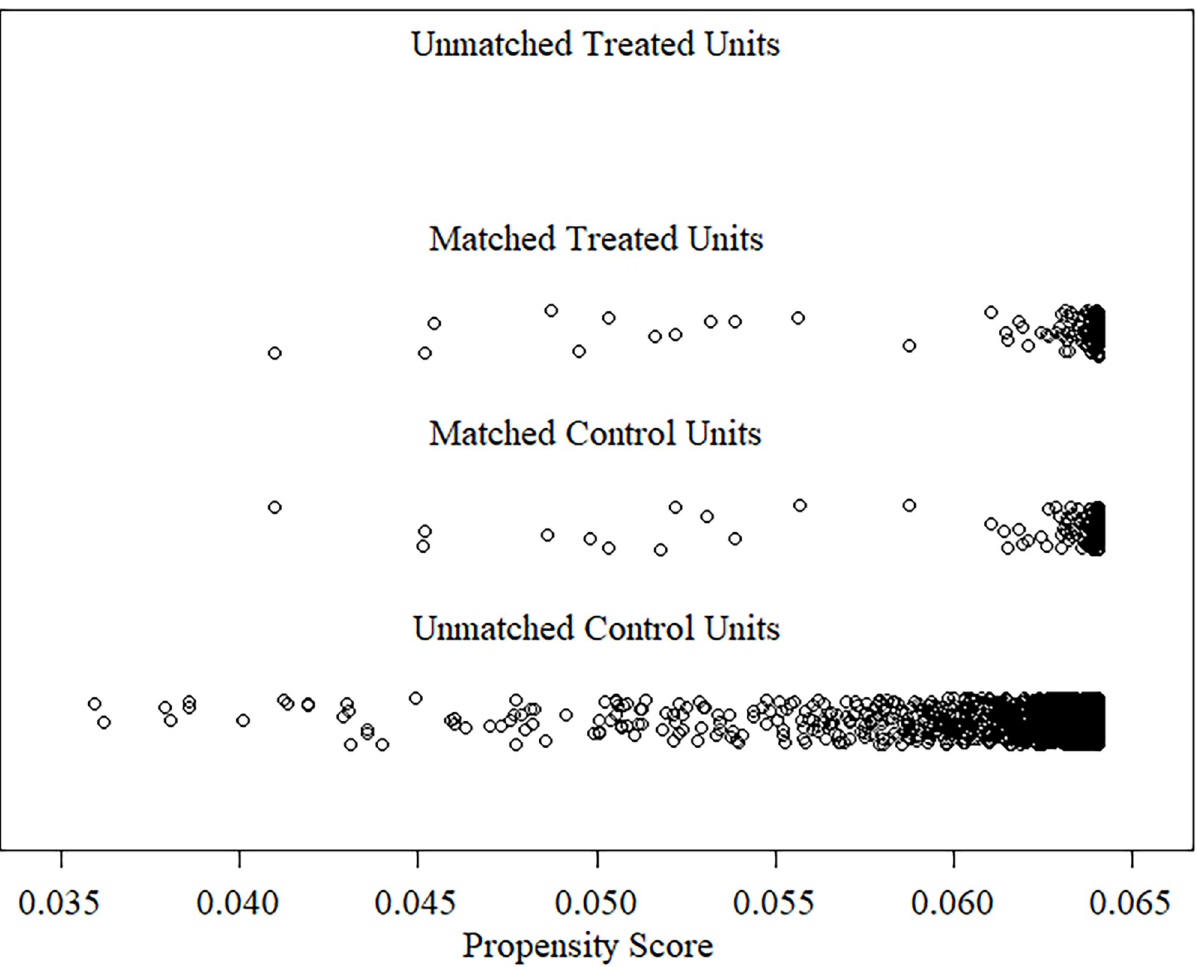
Fig 2. Propensity scores of matched and unmatched samples. R elaxing games are the treated units and control games are the control units.